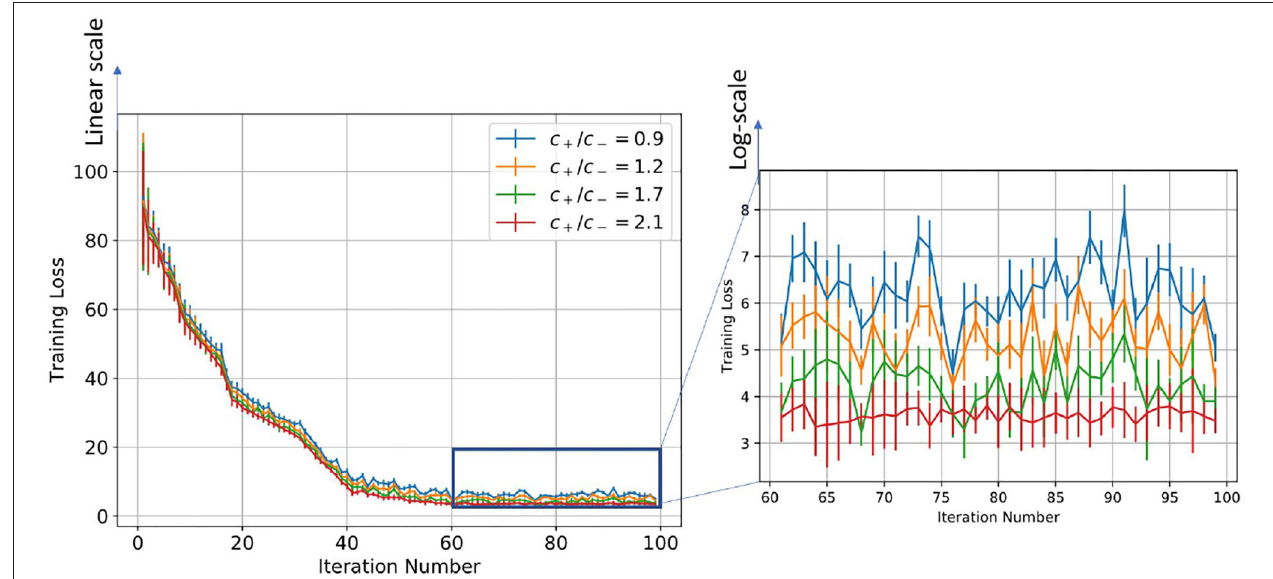
FIGURE 7 | Figure showing the change in training loss with iterations for varying scaling function ratios for the log-STDP learning process.